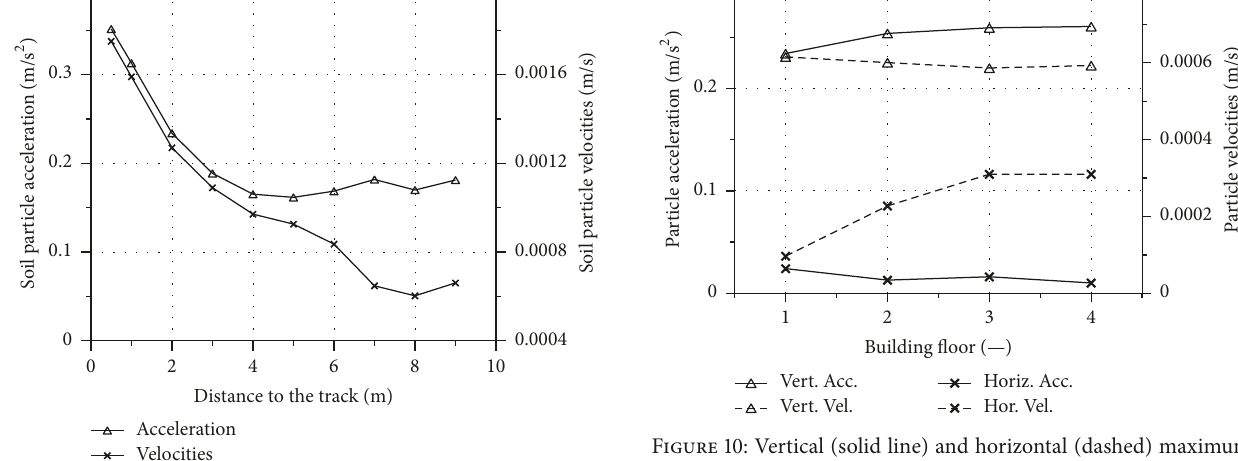
Figure 8: Soil particle acceleration and velocities at different distances to the track.